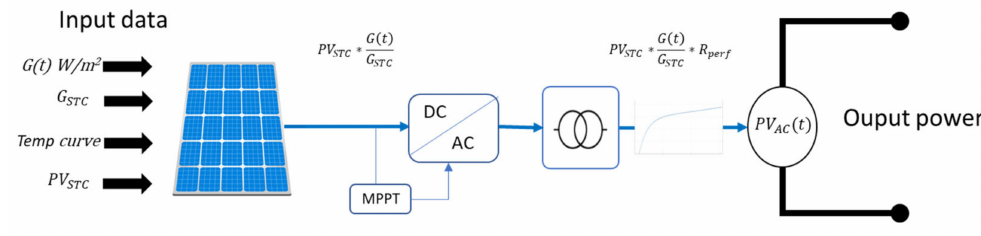
Figure 12. Behavioral model of PV G .